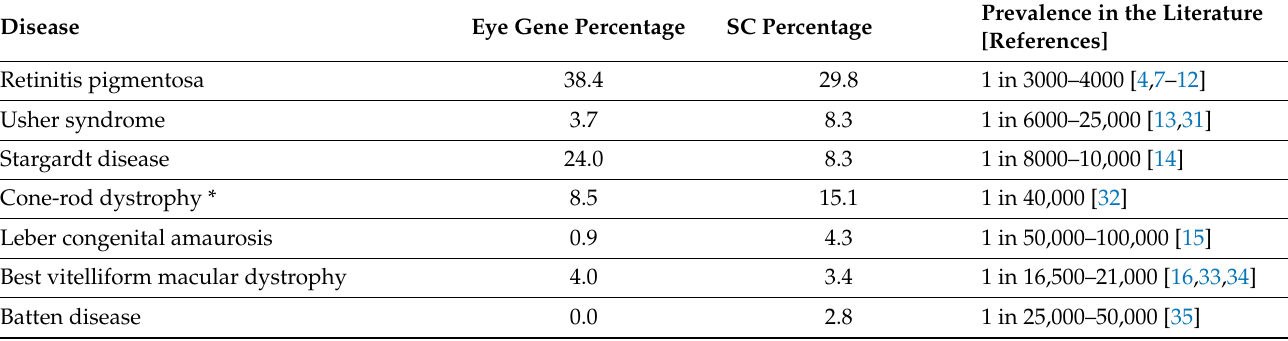
Table 3. Relative proportions of IRDs in the eyeGENE report [20] compared to that of our southeastern US